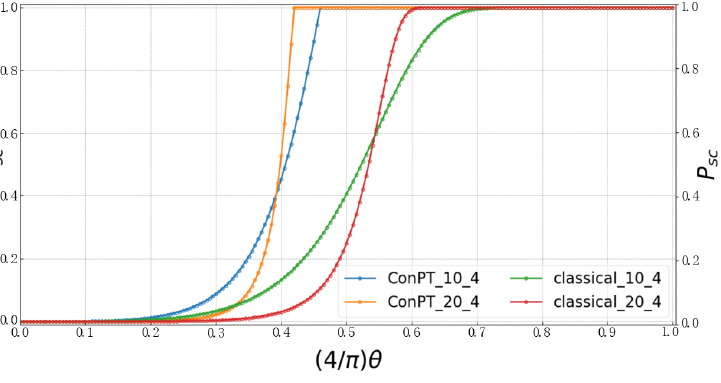
Figure 12. ConPT and classical percolation in a WS quantum network with average degree ¯ k =